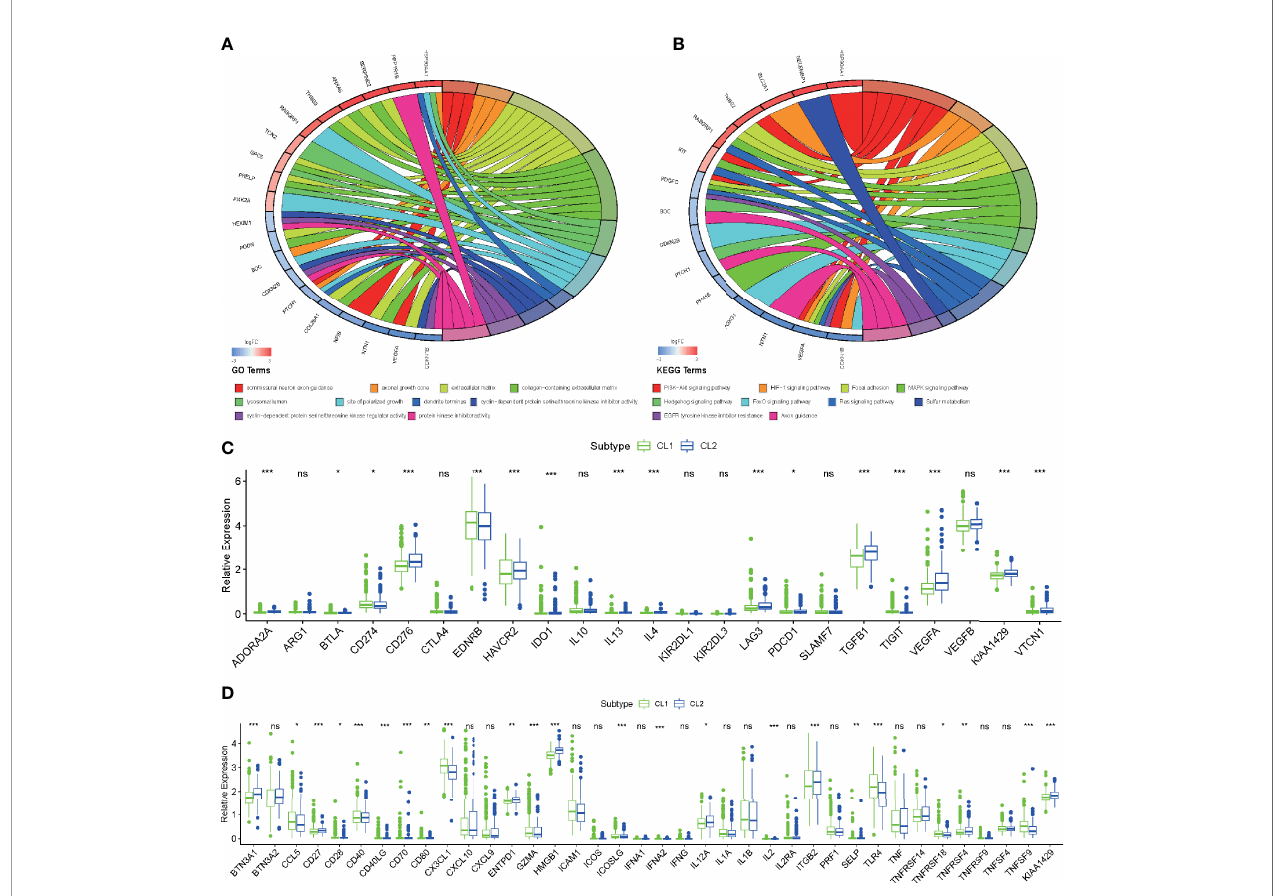
FIGURE 4 | Functional enrichment analysis of key genes and critical modules. (A, B) Functional annotation of the hub genes in the molecular subtype modules with GO analysis (A) and KEGG pathway analysis (B) . (C, D) Differences in the expression of immunosuppressive (C) and stimulator genes (D) in the CL1 and CL2 subgroups. The upper and lower ends of the boxes represented an interquartile range of values. The lines in the boxes represented the median value, and the dots showed outliers. The asterisks represented the statistical p-value (*P < 0.05; **P < 0.01; ***P < 0.001, ns, no signi fi